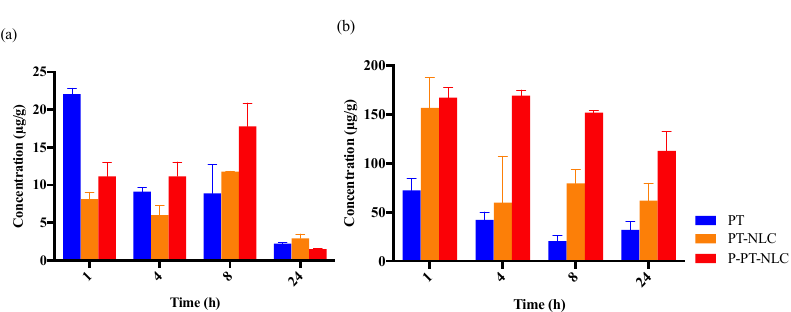
Figure 8. Biodistribution at the 10 mg / kg dose of PT, PT-NLC and P-PT-NLC in kidney ( a ) and liver ( b ) at 1, 4, 8 and 24 h. Each column represents the mean ± SD ( n = 2).